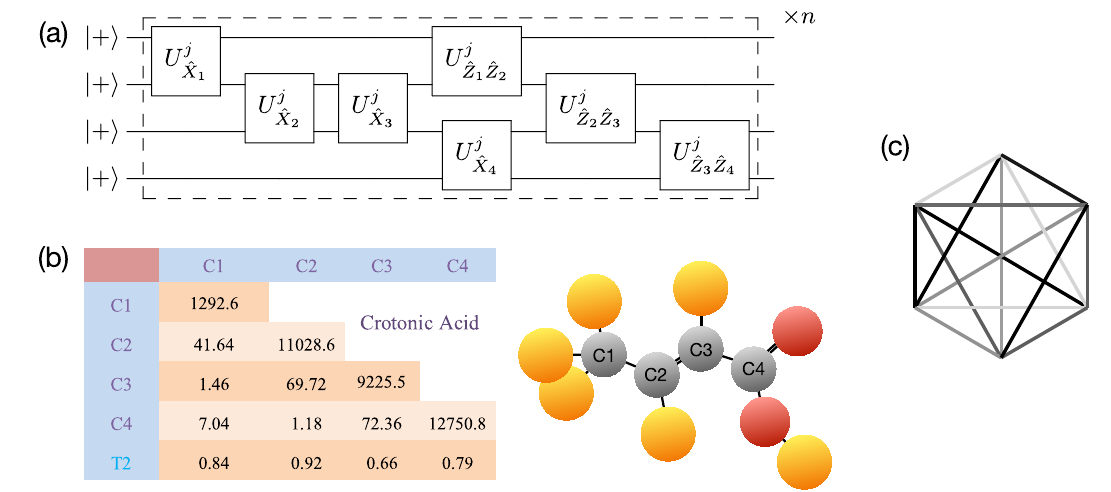
Fig. 1 Theoretical and experimental setup. a Quantum circuit of the quantum imaginary time evolution (QITE) for the transverse- fi eld Ising model with 4 represents the unitary operator that approximates e (cid:3) Δ τ ^ P for the local Hamiltonian ^ P in the j -th Trotter step. b Molecule qubits and n Trotter steps. U j ^ P structure and nuclei parameters of the nuclear magnetic resonance processor. The molecule has four Carbon atoms C1, C2, C3, and C4. Diagonal entries of the table are the chemical shifts in Hz, off-diagonal entries of the table are the J -couplings between two corresponding nuclei. The T 2 row gives the relaxation time of each nucleus. c A six-vertex complete graph with weighted edges. Different shades of gray represent different couplings in the Sherrington – Kirkpatrick